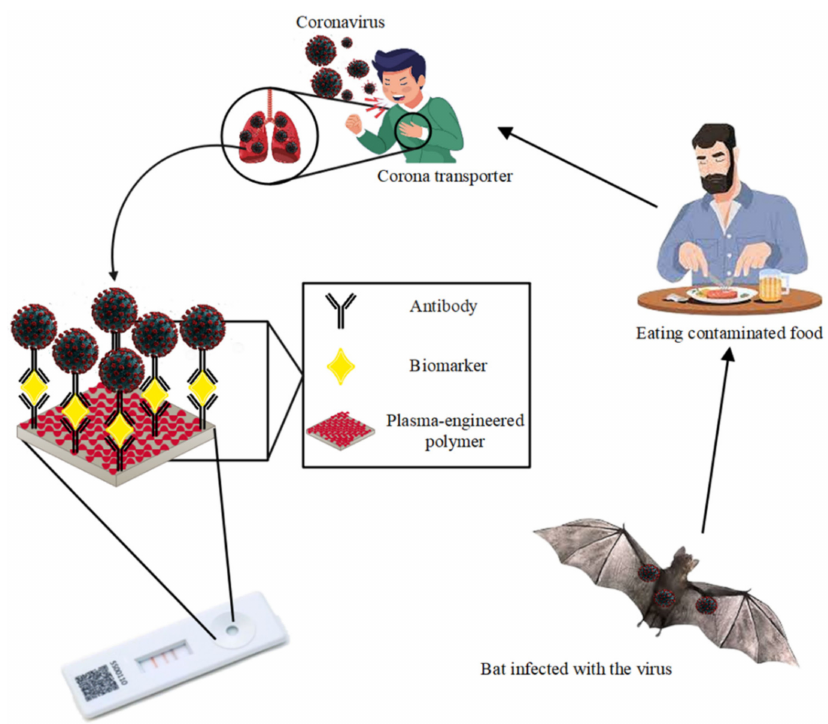
Figure 7. Detection of coronavirus by plasma-engineered polymer-based